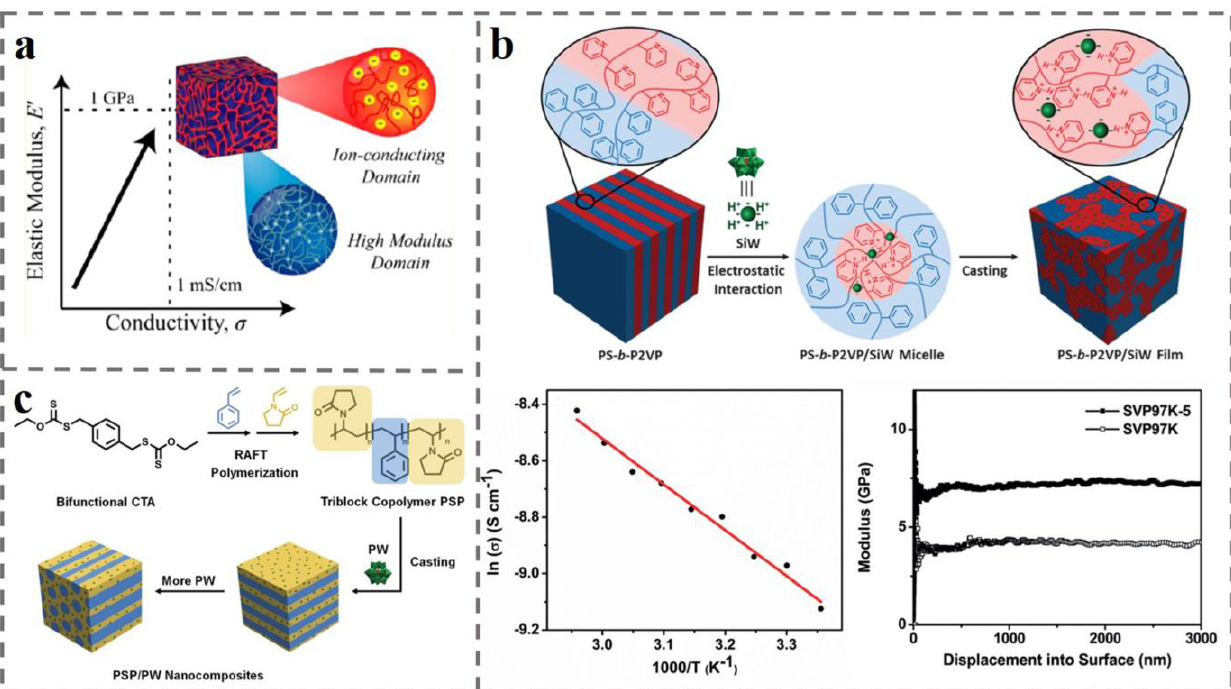
Figure 9. ( a ) BMITFSI induces PS-b-PEO to form a bicontinuous phase microdomain structure and enhances the elastic modulus E ’ and conductivity σ of PS-b-PEO [194]. ( b ) The electrostatic interaction between SiW and PS-b-P2VP induces the formation of a bicontinuous phase favorable to proton conduction, leading to an increase in proton conductivity and Young ’ s modulus [195]. ( c ) PW induces PVP-b-PS-b-PVP by electrostatic interaction to form a proton-conducting continuous phase with cylindrical, mechanically enhanced phase with great proton-conduction advantage [196].